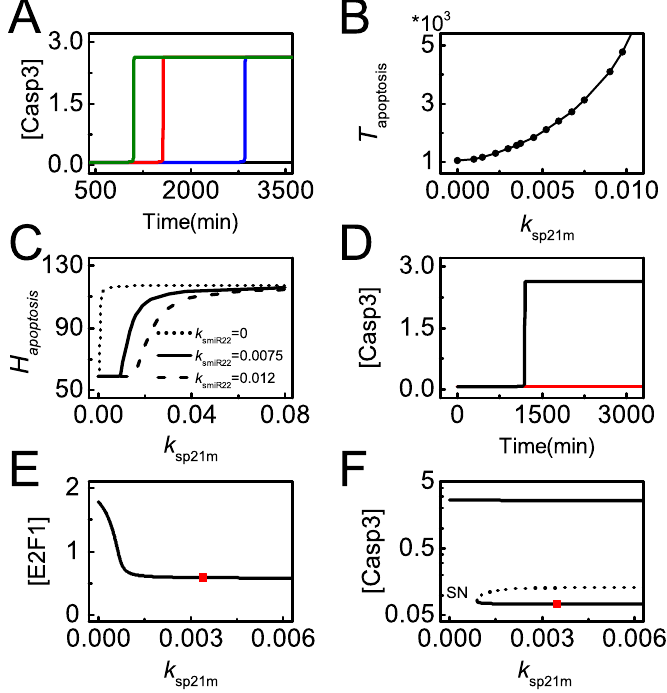
Figure 8. p21 downregulation promotes miR-22-dependent apoptosis. ( A ) Time courses of [Casp3] with DD = 100 and k sp21m = 0.001 (green), 0.0035 (red, the default case), 0.007 (blue) or 0.018 (black); ( B ) the curve of T apoptosis (time required for Casp3 activation) versus k smiR22 ; ( C ) the curves of H apoptosis versus k sp21m for different k smiR22 ; ( D ) time courses of [Casp3] for DD = 100 with k sp21m = 0.0003 (black) or 0.0035 (red, the default case) in the case of miR-22 knockout; ( E , F ) Bifurcation diagram of [E2F1] and [Casp3] versus k sp21m with k smiR22 = 0 and DD = 100. k sp21m takes the default value at the position marked by the red square. “SN” denotes saddle-node bifurcation